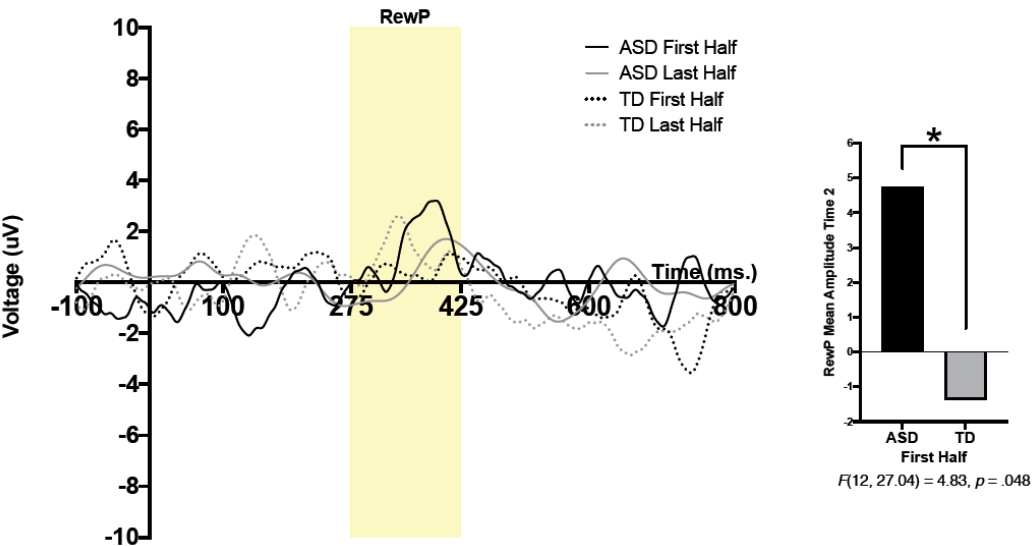
Figure 1. Grand average waveforms during the first and second halves of trials in participants with and without ASD at Time 2 (post-intervention). Significant differences were observed between the ASD and TD groups during the first half of trials at Time 2 (post-intervention). Note that for the purposes of this figure, the ERP was filtered using a 25 Hz low-pass filter. * p < 0.05.